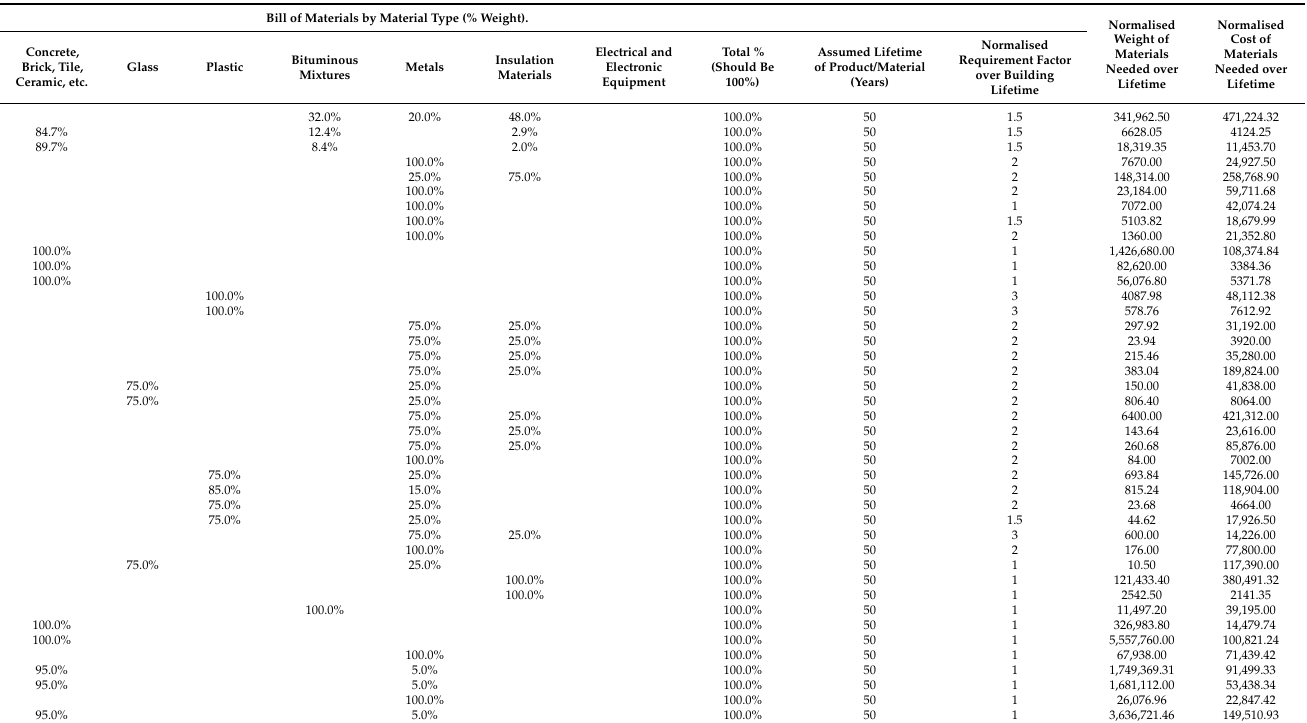
Table A2. Bill of materials input of shell building elements according to material type for the analysed retail store, in terms of percentage of weight for each building element, assumed lifetime and replacement factor, according to Level(s) template